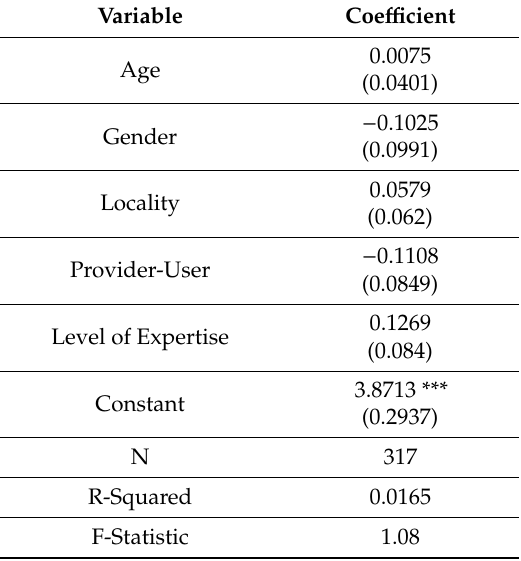
Table 6. Accounting for